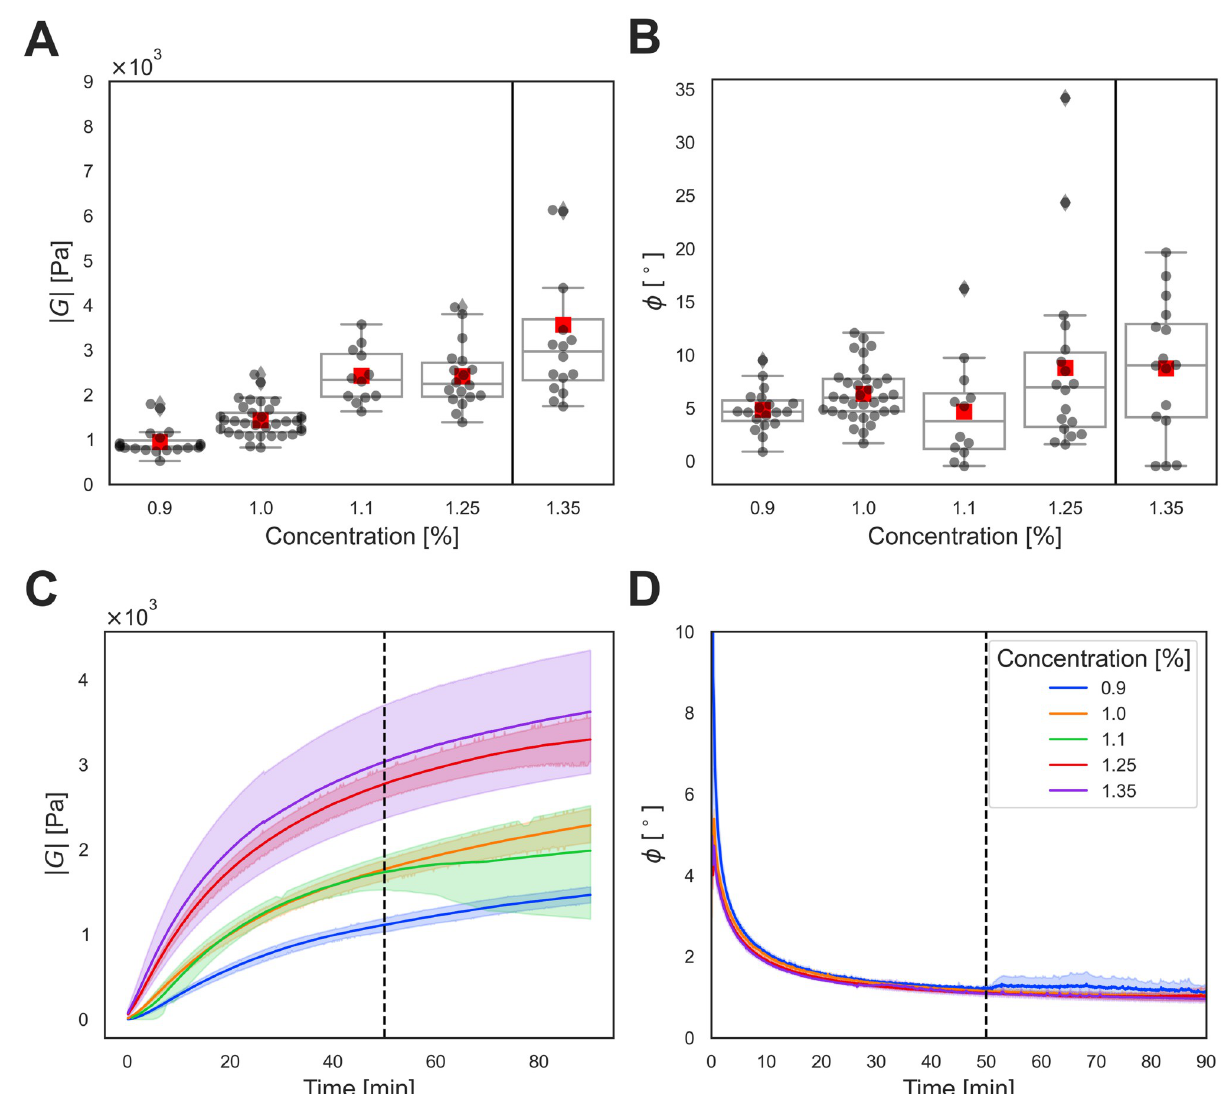
Fig 6. Pointwise microscale viscoelasticity measurements of breast tumor tissue-relevant stiffness levels. A–B : Absolute shear modulus (| G |) and phase angle ( ϕ ) values of agarose matrices with increasing concentration measured using the 100 μ m magnetic spheres and the magnetic microrheometer. Agarose matrices with a concentration up to 1.25% can be measured, whereas the signal-to-noise ratio significantly reduces for higher concentrations, including 1.35%, for which measurements are considered unsuccessful. Therefore, the 1.35% agarose condition is separated by a black vertical line from other measurements. The successful microrheometer measurements of | G | for the 1.25% agarose matrix with mean ± standard deviation values of 2.41 ± 0.70 kPa correspond to Young’s moduli (E) from 6.61 ± 1.93 kPa ( v = 0.37) to 7.24 ± 2.11 kPa ( v = 0.50). Multiple individual measurements of | G | exceed 3.5 kPa, denoting 10–11 kPa in Young’s modulus ( v = 0.37–0.50). For both plots, the dark grey spheres show values measured by individual magnetic spheres, while the red squares are the mean values of the spheres. Standardly, the plots’ box and whiskers indicate the lower/upper extremes, the 25% and the 75% percentiles, and the median. C–D : Absolute shear modulus (| G |) and phase angle ( ϕ ) values of the agarose matrices at the used concentrations were validated using parallel-plate rheology. The dashed vertical line corresponds to a timepoint of 50 min after the start of the measurements, relevant to microrheological measurements. The curves with darker colors indicate the mean values of the data for each agarose concentration, while the lighter shaded-color regions indicate the lower 5% and the upper 95% percentiles for the data. https://doi.org/10.1371/journal.pone.0282511.g006 used to confirm the measured absolute shear modulus and phase angle values (Fig 6C and 6D). These microrheology measurements that report the microscale values within each sample are well distributed around the average value obtained with the macroscale parallel-plate rheo- metry, validating the measurements.